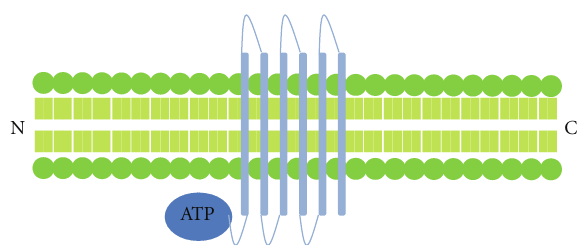
Figure 4: Structure of Breast Cancer Resistance Protein (BCRP)— this ABC transporter contains 6 transmembrane domain and 1 ATP binding site on the amino terminal side of the transmembrane domain. This is known as a “half transporter,” these are thought to form dimmers in order to